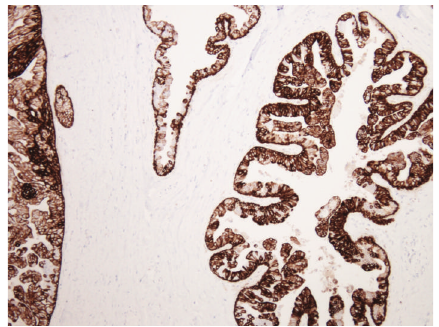
Figure 4: CK 5/6 immunostaining, × 200.